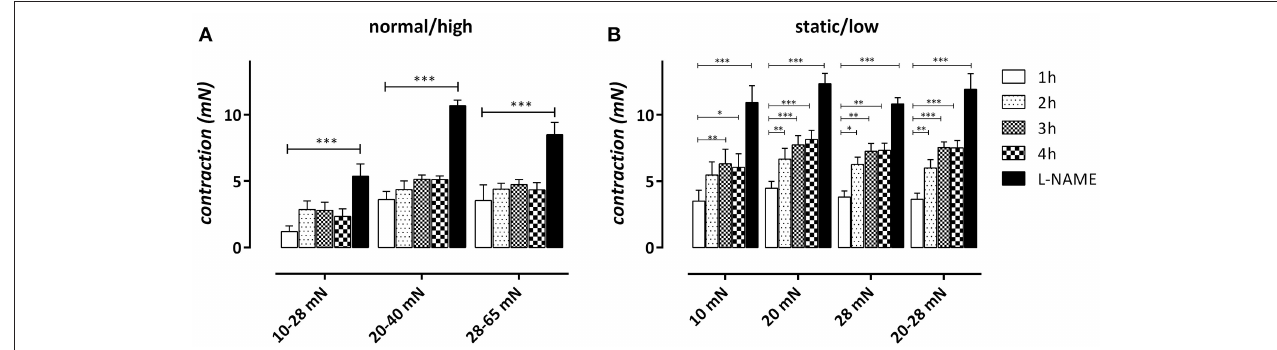
FIGURE 6 | “Steady-state” effects of 2 µ M PE in aortic segments subjected to normal/high cyclic stretch (A) or static/low cyclic stretch (B) . Contractions were measured 1, 2, 3, and 4h after mounting and after 300 µ M L-NAME was added to determine the maximal contraction by inhibiting relaxing basal NO release. * P <